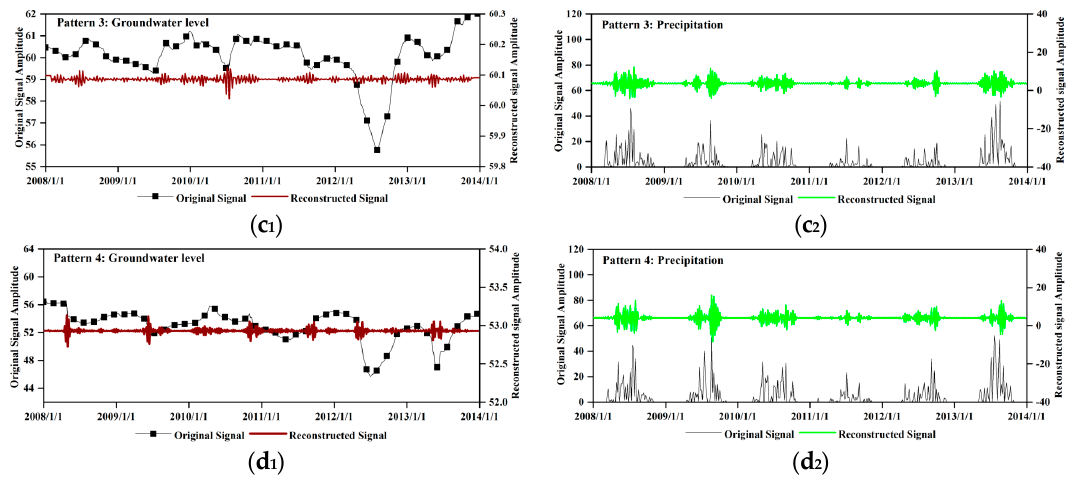
Figure 8. Reconstruction of original signals between groundwater level and precipitation in the Naoli River Basin, Northeast China, during 2008–2013, based on the continuous wavelet using fast Fourier transform (CWTFT) method for pattern 1 ( a ); pattern 2 ( b ); pattern 3 ( c ); and pattern 4 ( d ),